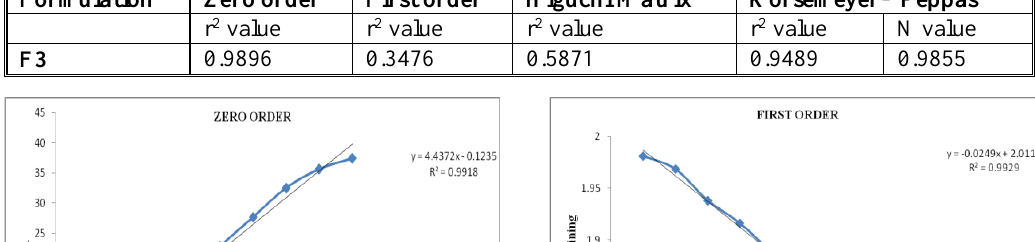
Table 5. Regression co-efficient (r 2 ) values of different kinetic models and diffusion exponent (n) of Peppas model for optimized formulation (F3) Formulation